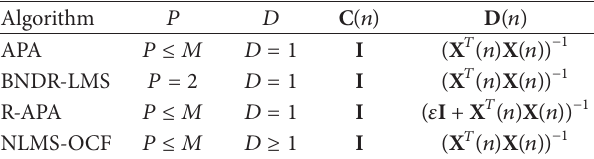
Table 1: Family of APA adaptive filter algorithms.